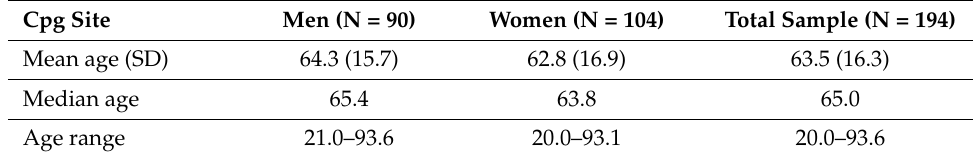
Table 1. Age distribution of the analyzed